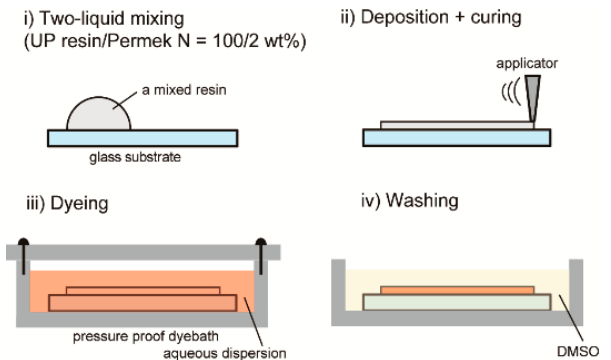
Figure 1. Structural formula of CACzE and background photograph of CACzE powder.